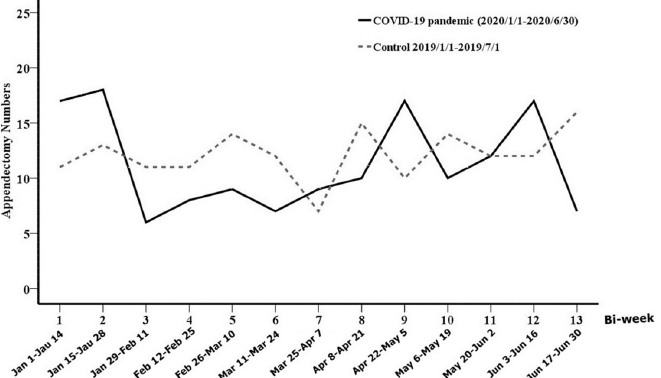
Fig 2. Temporal trend of the number of surgeries for acute appendicitis in a serial bi-weekly manner (study group: January 1, 2020–June 30, 2020; control group: January 1, 2019–July 1, 2019; leap year: 2020). The line of the study group depressed from the third bi-week (January 29–February 11) to eighth bi-week (April 8–April 21). Dates are shown for the study group; for the control group, add 1 day to each date after February 28.